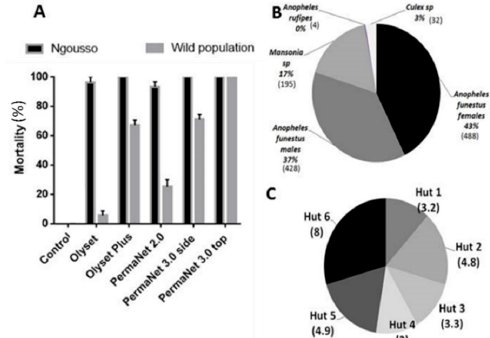
Figure 1. Quality control before the experimental hut trial in Mibellon: Species composition in Mibellon: ( A ) Quality control of the e ffi cacy of all the four nets checked against the susceptible laboratory strain of Anopheles gambiae Ngousso and LLINs e ffi cacy testing using cone assays against the pyrethroid resistant An. funestus population from Mibellon, Cameroon; ( B ) Number of mosquitoes collected during the hut e ff ect assessment; ( C ) Average of Anopheles funestus. ss collected by hut during the 18 days of the hut e ff ect